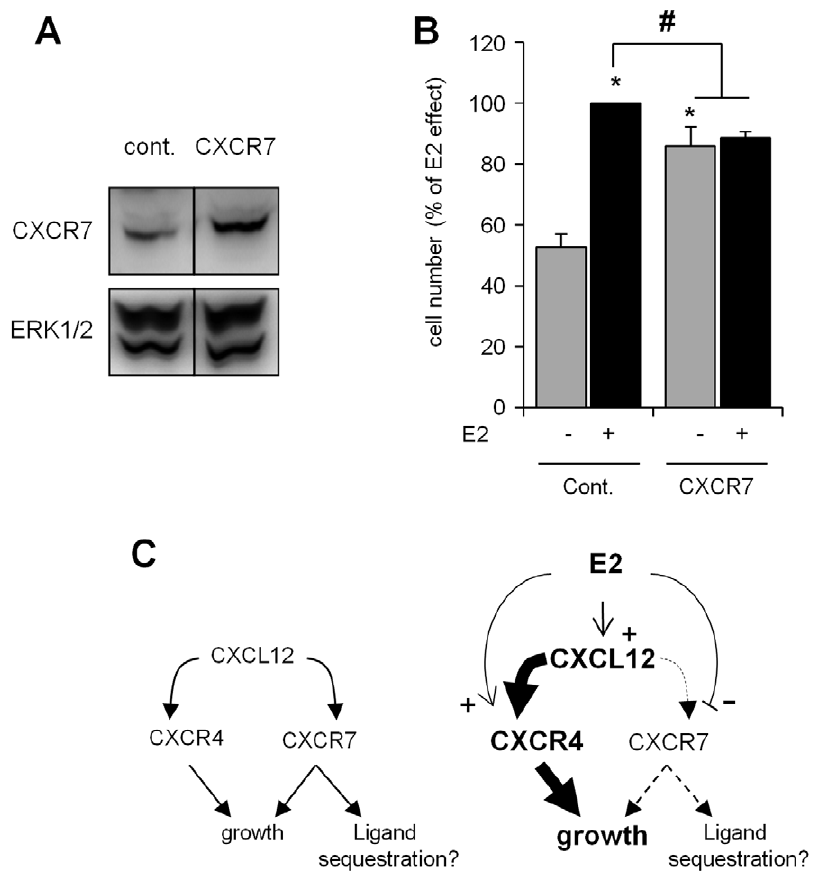
Figure 6. Impact of CXCR7 over-expression on the E2-dependent and -independent growth of MCF-7 cells. MCF-7 cells were transiently transfected with either a control expression vector or one containing the human CXCR7 open reading frame. (A) Total protein extracts were prepared 48 h after transfection, and a Western blot analysis was performed to confirm CXCR7 over-expression. (B) Transfected cells were cultured in the presence of EtOH ( 2 ) or 10 2 8 M E2 ( + ) for seven days. E2-dependent and E2-independent cell growth rates were then evaluated by cell count of three independent experiments (n=3). The results are expressed as a percentage of the relative cell number obtained from control cells treated with E2 (considered as 100%). Significant differences ( p , 0.05) between transfected cells in the absence of E2 are indicated by an asterisk and between transfected cells in the presence of E2 by a sharp symbol. (C) A proposed model for the involvement of the CXCL12 signaling axis in E2-dependent and -independent cell growth is shown. The binding of CXCL12 to CXCR4 and CXCR7 leads to the stimulation of cell growth through diverse pathways [28]. CXCR7 can also modulate CXCL12 availability by removing the chemokine from the extracellular space (left panel). Estrogens could stimulate cell growth by favoring the activation of CXCL12 through CXCR4 and reducing the expression of CXCR7 (right